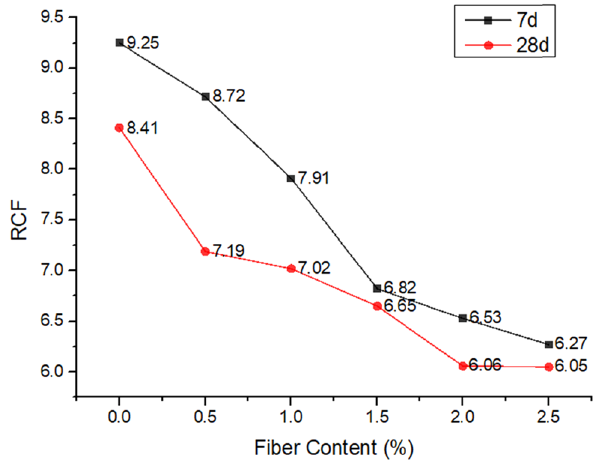
Figure 19. The modi fi cation mechanism is similar to the tensile strength and therefore it is not explained here.